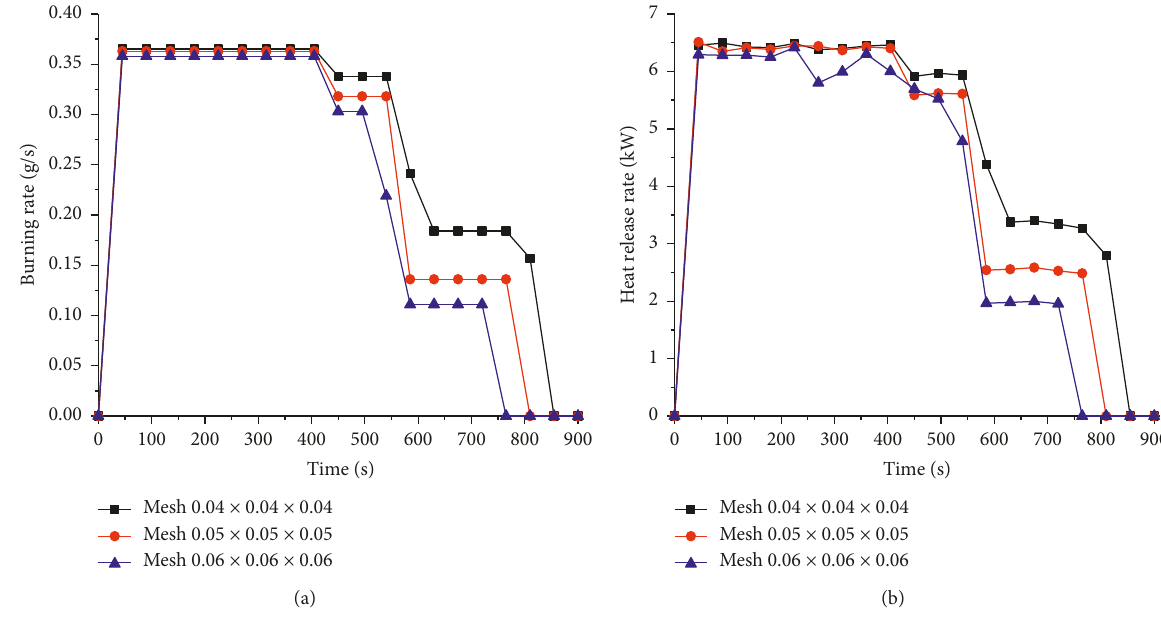
Figure 3: (a) The burning rate and (b) heat release rate with different grid size.